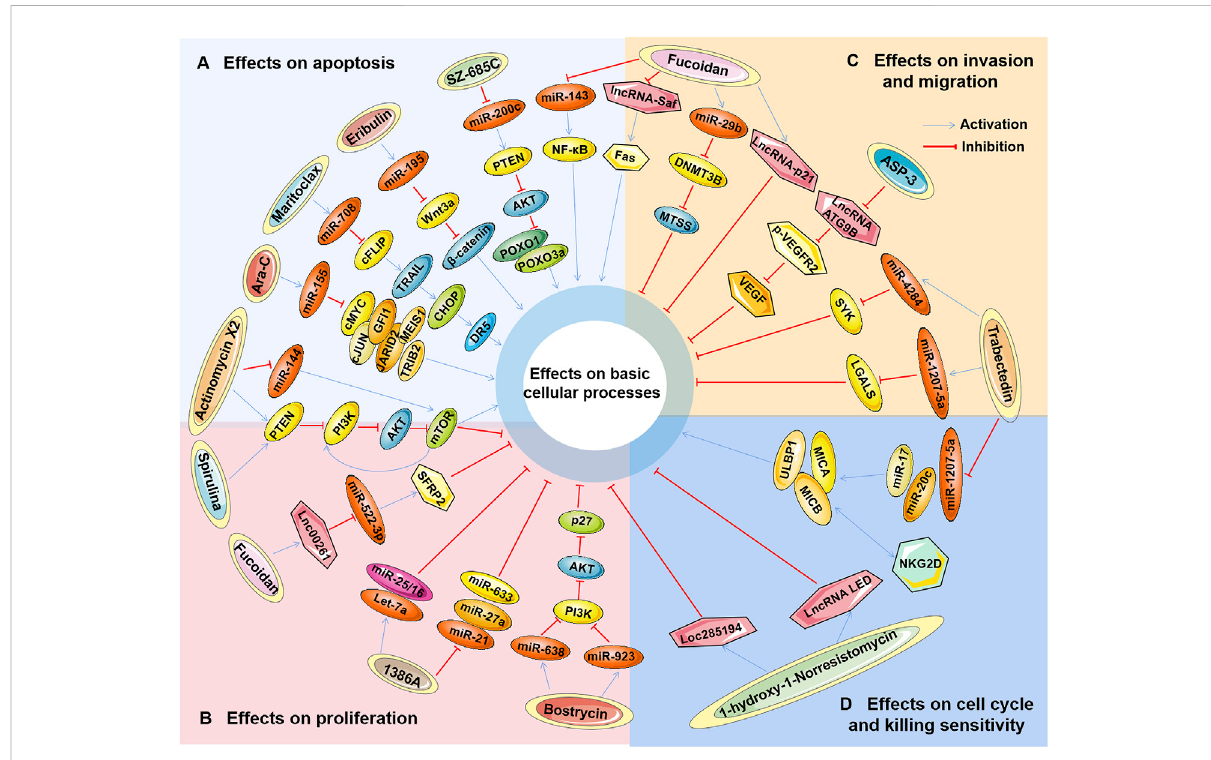
FIGURE 3 Theantitumoreffectsofmarine-derivedantitumoragentsmediatedbynon-codingRNAsinbasiccellularprocesses.Marine-derivedantitumor agents (SZ-685C, eribulin, maritoclax, trabectedin, spirulina, bostrycin, cytarabine, fucoidan, 1386A, actinomycin X2,1-hydroxy-1-norresistomycin, and ASP-3) can induce tumor cell apoptosis (A) , inhibit cell proliferation (B) , invasion, and metastasis (C) , inhibit cell cycle arrest, and enhance tumor cell-killing sensitivity to immune cells (D) by upregulating oncogenic noncoding RNA (ncRNA), or downregulate tumor suppressor